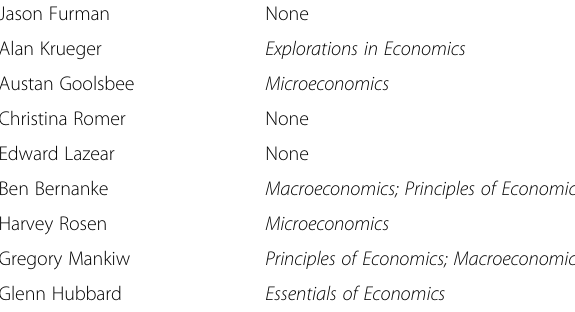
Table 1 CEA heads of Bush II and Obama administrations as textbook